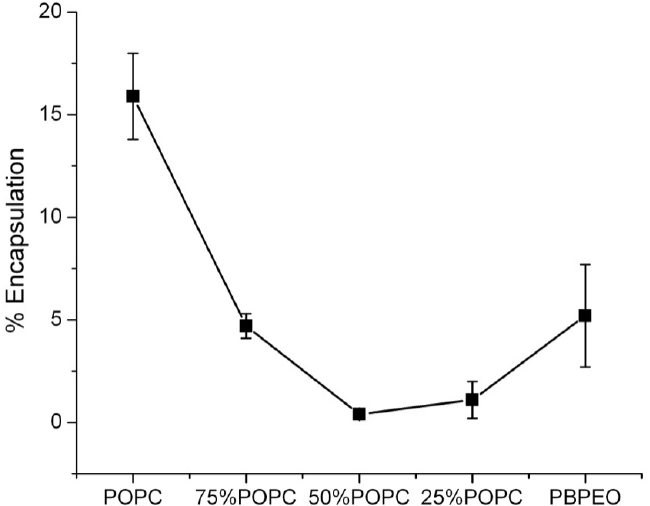
Figure 5. The effect of PB-PEO molar ratio on the encapsulation efficiency of the